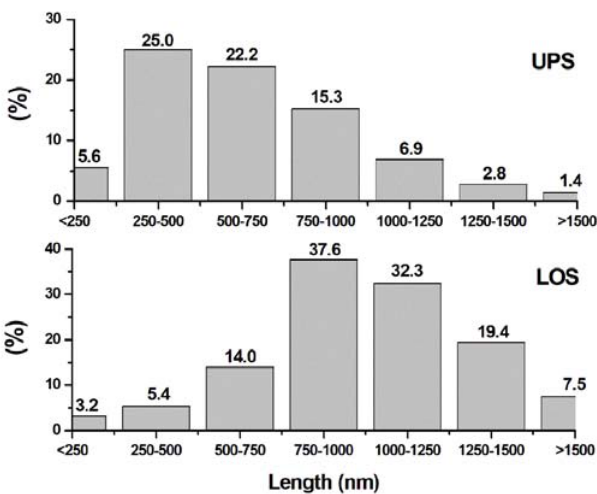
Figure 7. The distributions of the lengths of halloysite from TEM for the UPS and LOS samples. Unit is nanometer (nm).